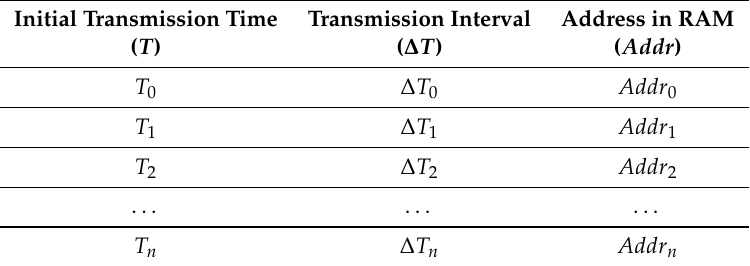
Table 2. The Definition of the Traffic Schedule